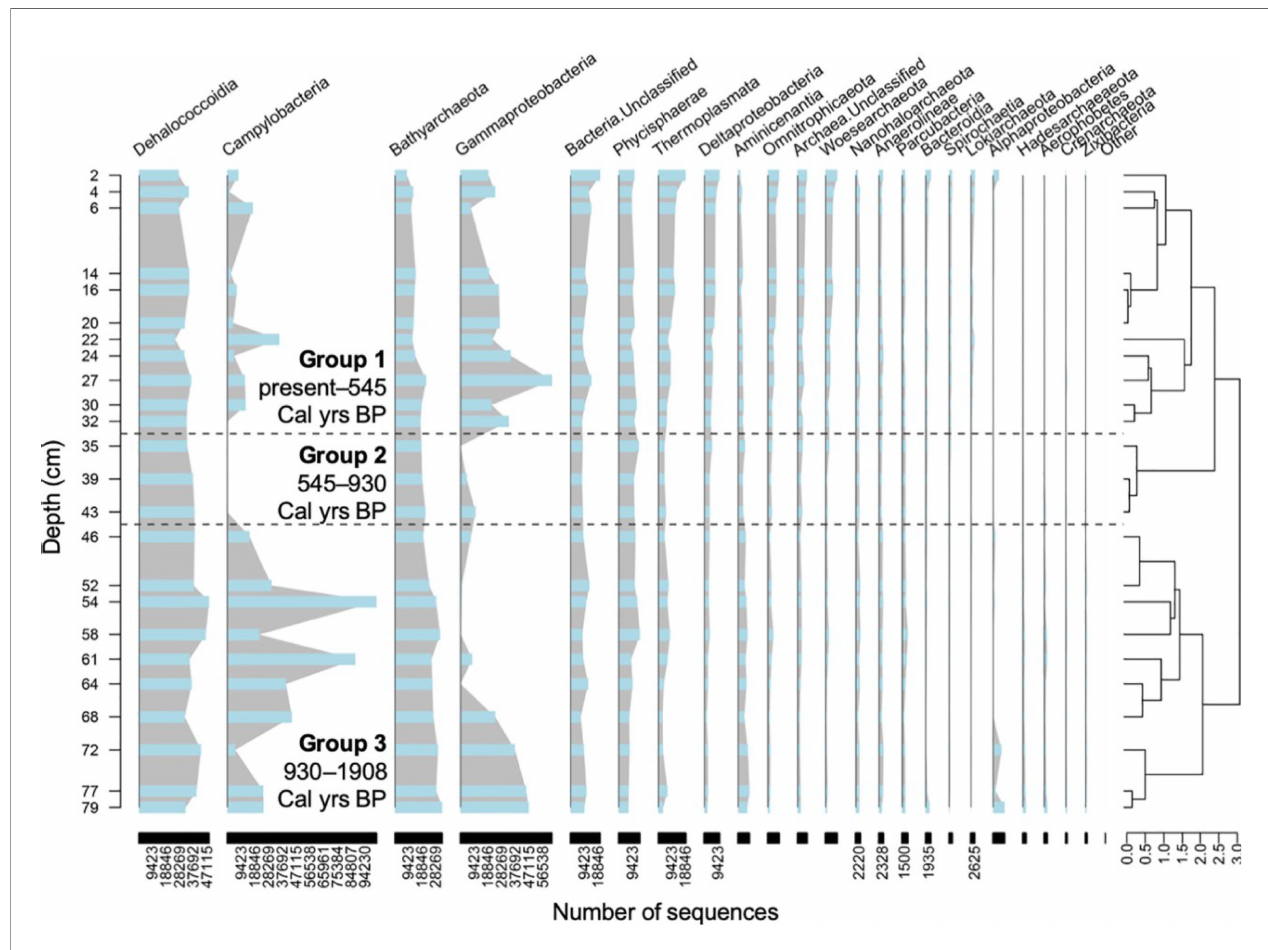
FIGURE 4 | Stratigraphically-constrained hierarchical cluster analysis of microbial community downcore based on the three previously determined age groups based on source of organic matter. Blue bars, linked by a grey area line, represent the number of ASVs for each